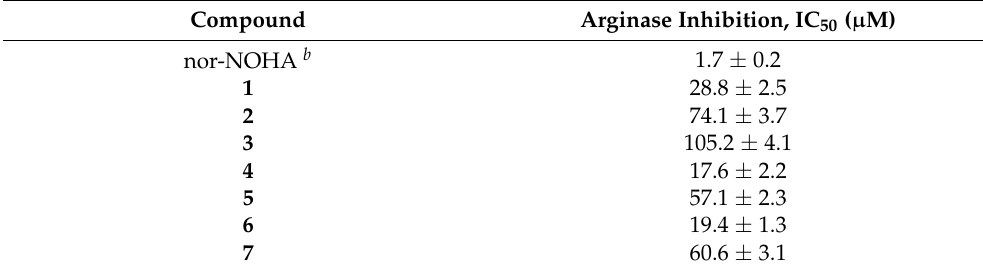
Table 5. Arginase inhibitory activity of compounds 1 – 10 a